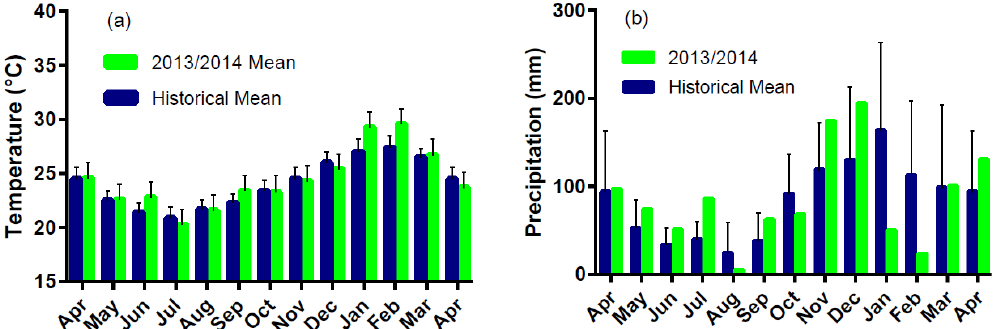
Figure 2. Meteorological conditions during the sampling period (in green) compared with historical values (1951–2014, in blue). (a) Presents the monthly accumulated precipitation; (b) presents the monthly average of atmospheric temperature.